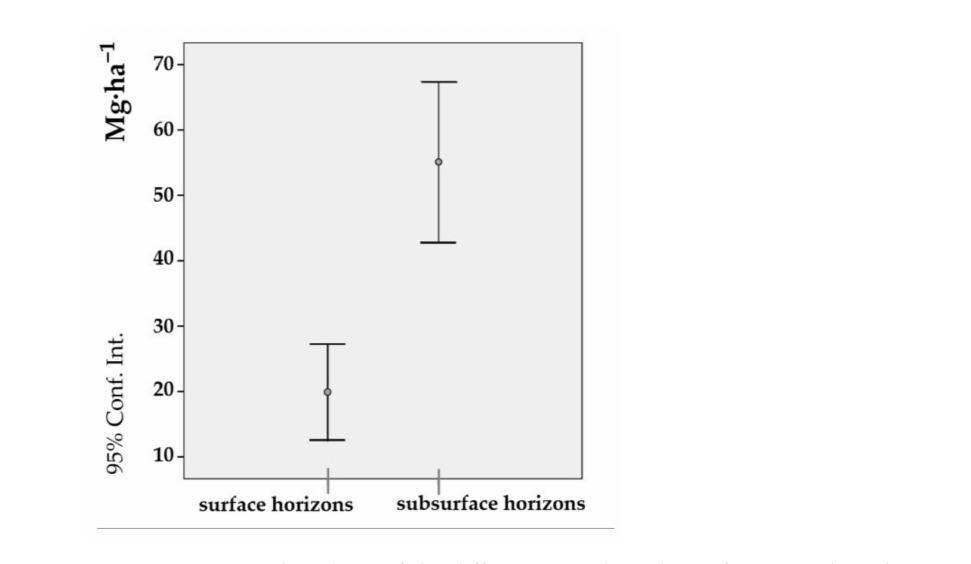
Figure 1. Statistical analysis of the differences in the values of SOC stock in the superficial and subsurface horizons (95% confidence intervals). Software: IBM SPSS Statistics